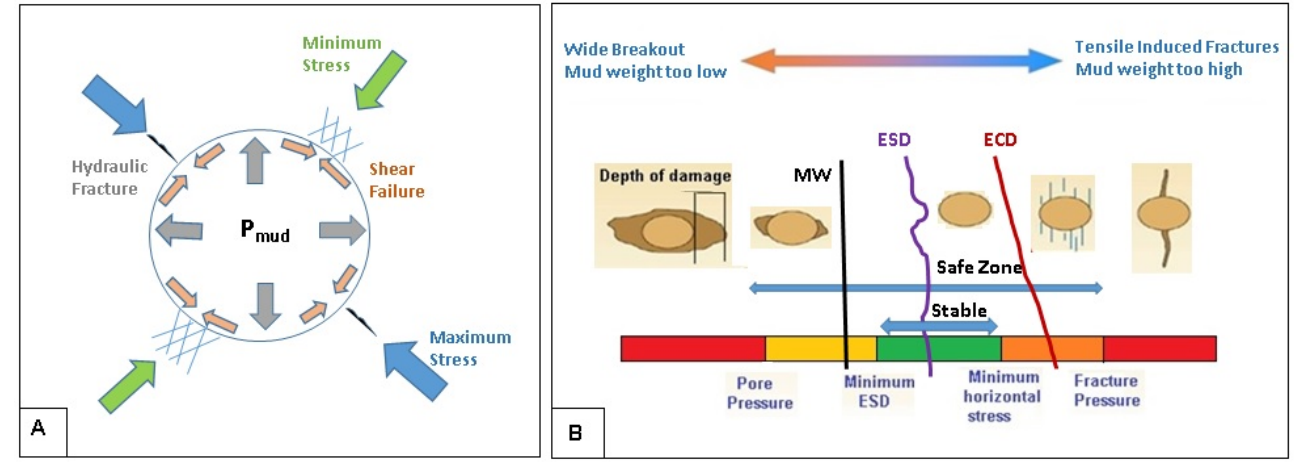
Figure 3. Stress and wellbore damage are depicted in this diagram. ( A ) The borehole’s maximum and minimum horizontal stress directions, ( B ) mud weight, and various bottom-hole pressures. ESD and ECD are the corresponding static and dynamic density in an arrangement, and MW is the mud window.